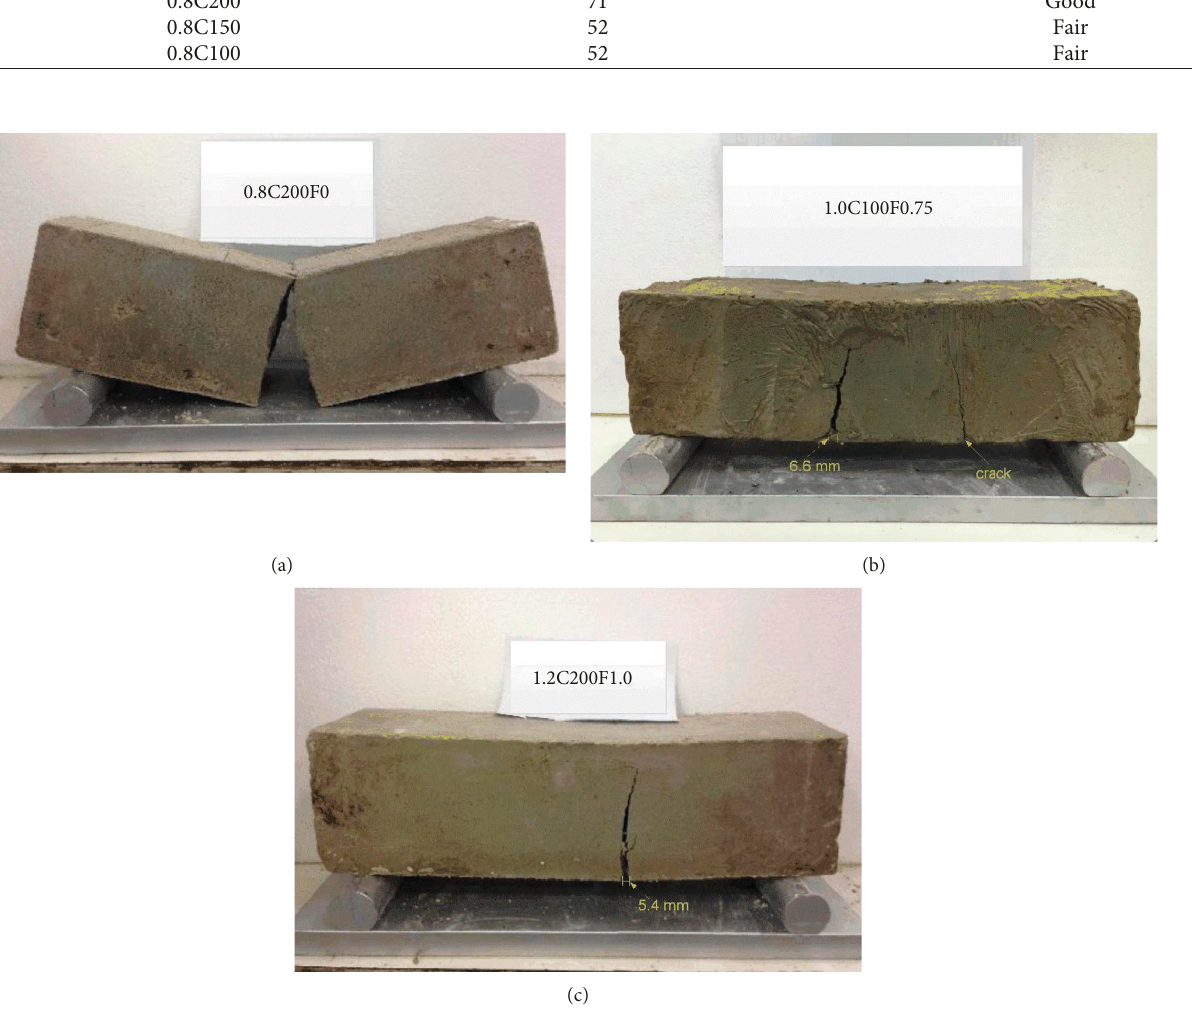
Figure 8: Photographs of the cracking pattern of